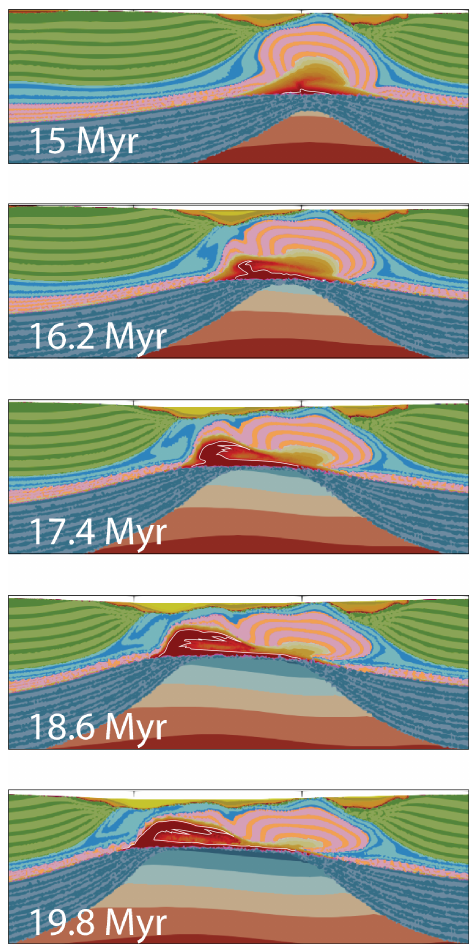
Figure 16. Zoom of the last 5Myr of evolution of the model of Fig. 15 with a liquidus temperature of 1000 ◦ C from 15 to 19.8Ma (black dotted rectangle in Fig. 15 for